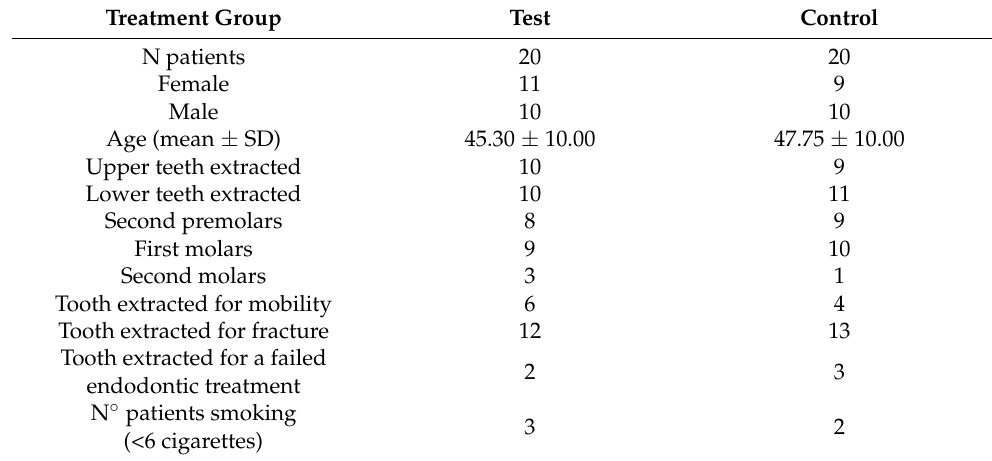
Table 1. Anamnestic data of two treatment groups of treatment; SD: standard deviation, N ◦ : “number